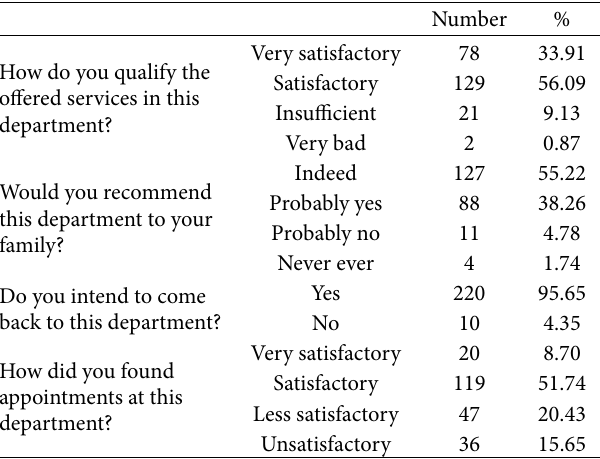
Table 2: Overall satisfaction of cancer patients (Hassan II CHU, Fez, 2017).